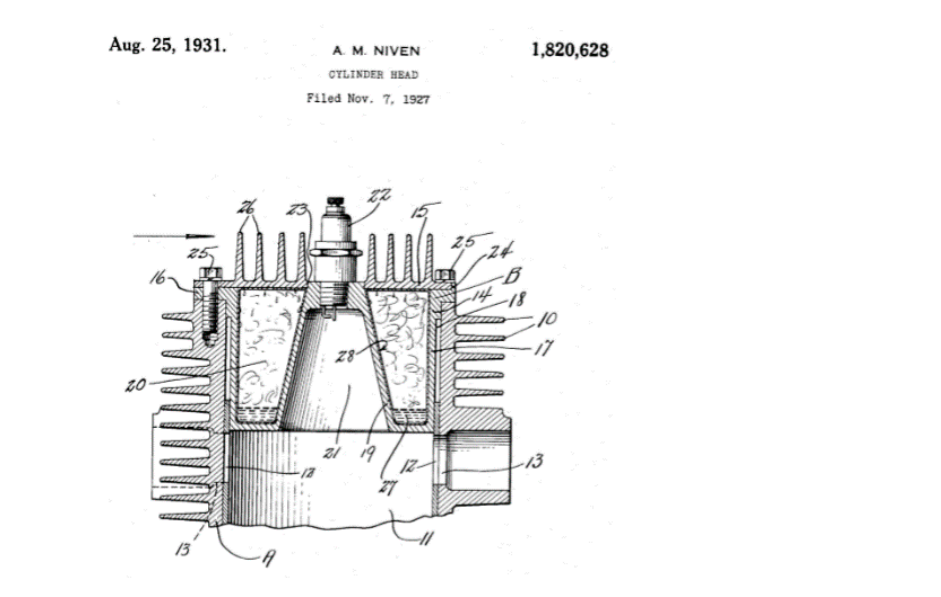
Figure 27. A.M. Niven Continental, cylinder head 25 August 1931, US 1820628. Reproduced with